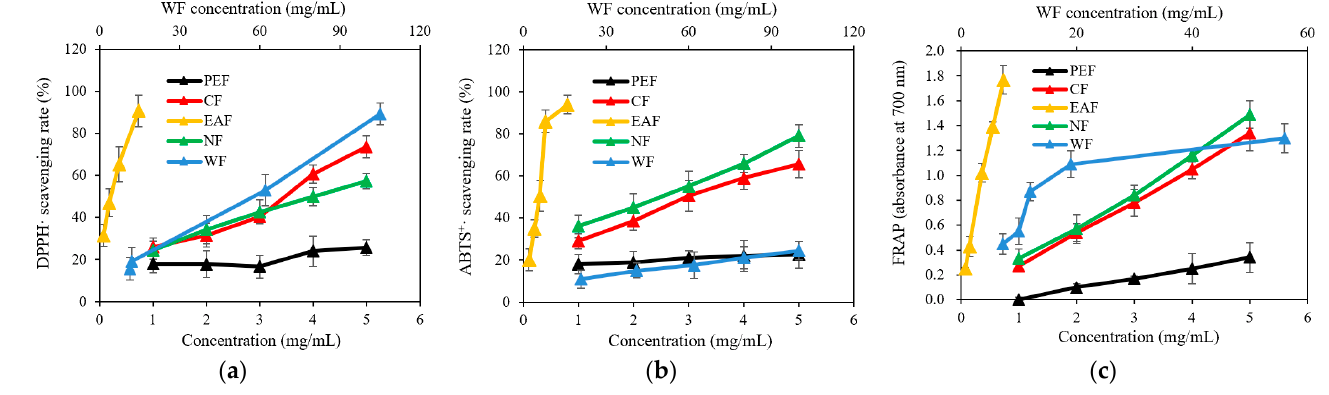
Figure 1. Antioxidant activity of the five extracted fractions from Pingguoli pear fermentation broth with different concentrations, including DPPH free radical scavenging rate ( a ), ABTS free radical scavenging rate ( b ) and FRAP ( c ). Values are showed as the mean ± SD ( n = 3). Table 2. Antioxidant activity of the five extracted fractions from Pingguoli pear fermentation broth. Fractions IC 50 (mg/mL) DPPH ABTS FRAP PEF